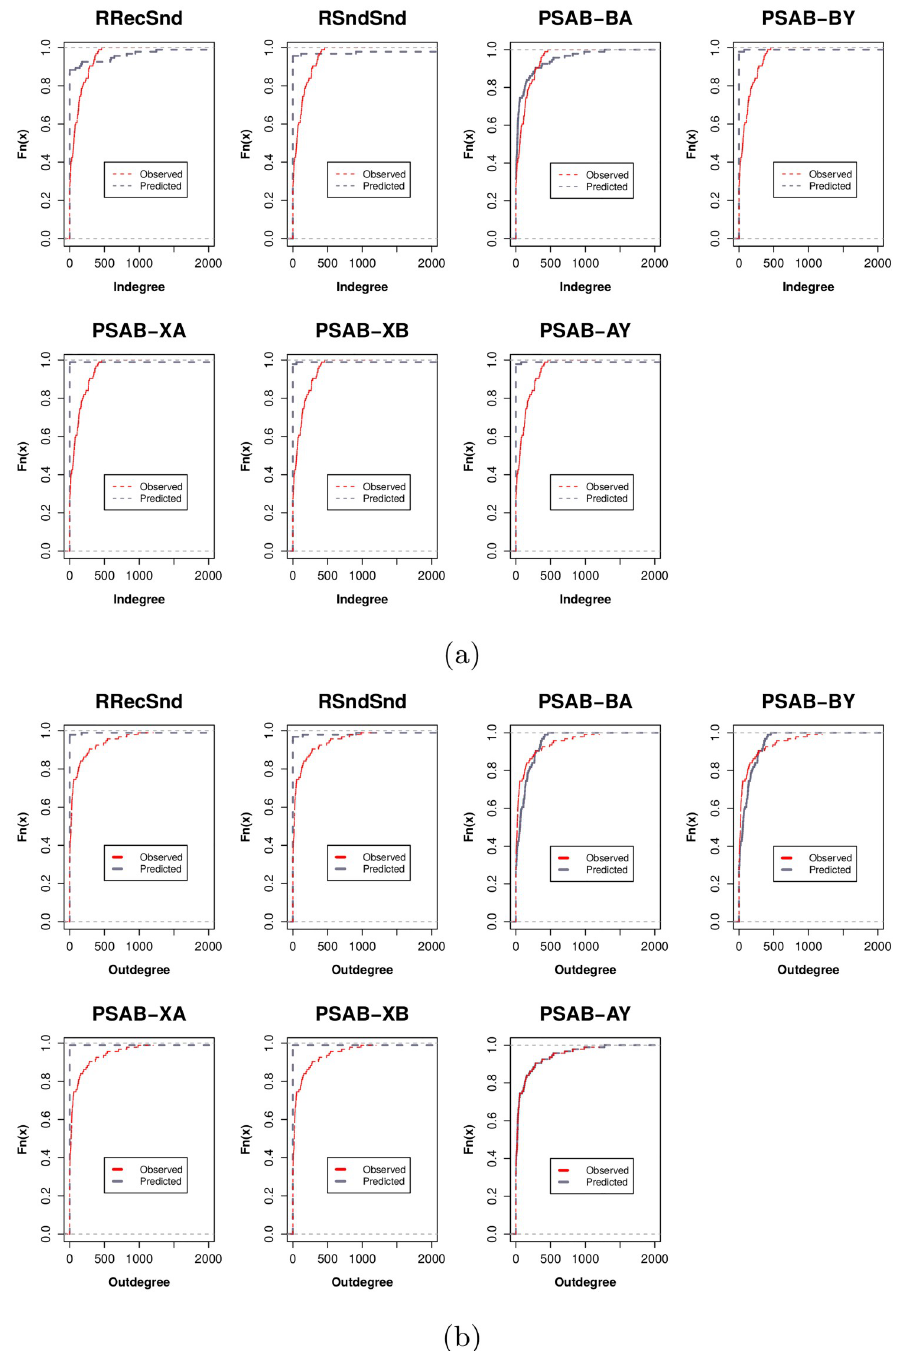
Fig 4. Relational events modeling of email comms. Parameters from a relational events model predicting sequential, dyadic communicative actions between actors in the network. The strongest effects (NIDSnd and NIDRec) represent preferential attachment, as those with greater indegree participate more in the future. The next strongest class of predictors are “burstiness” parameters (NODSnd and PSAB-AY). The effect size for PSAB-BA participation shift (turn-taking dynamics) is relatively smaller, but